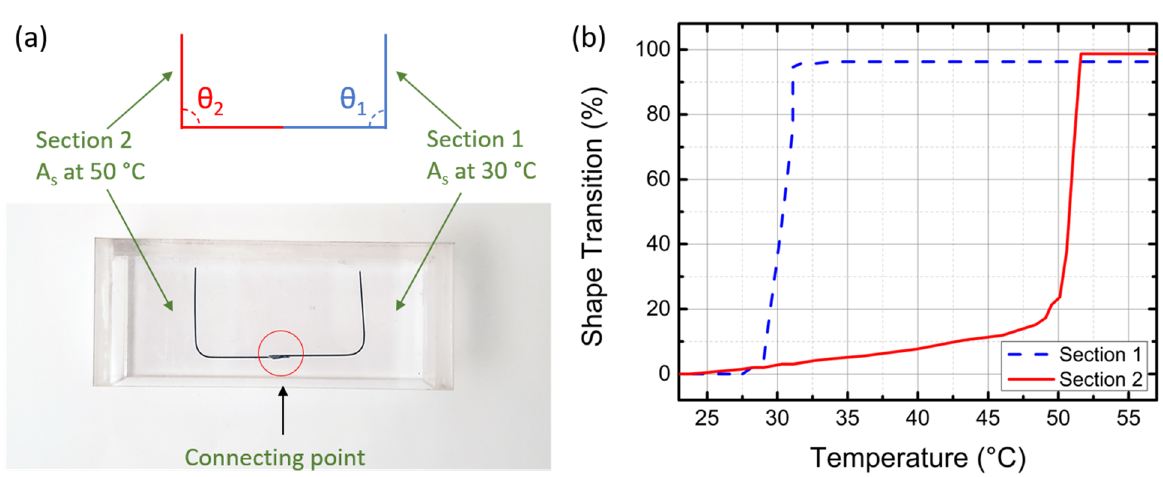
Figure 6. ( a ) Schematic and photo of multi-section SMA wire manually reset with an angle in both sections. ( b ) Temperature response of the SMA wire.